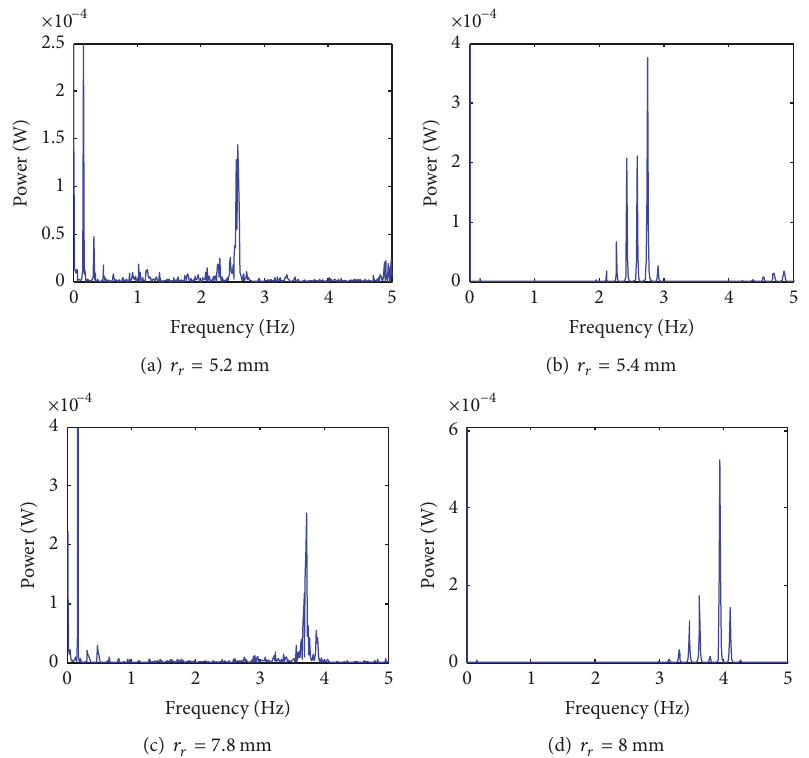
Figure 14: Power spectrum of vibration response of rotor for different theoretical radius.